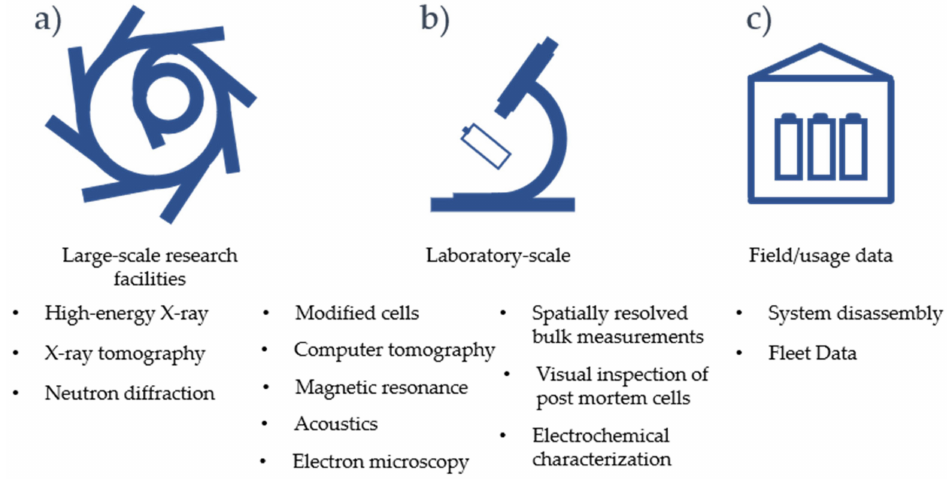
Figure 5. Different scales and complexity for ctcV and inhomogeneities measurements: ( a ) Large scale research facilities; ( b ) Laboratory-scale; ( c ) Field usage